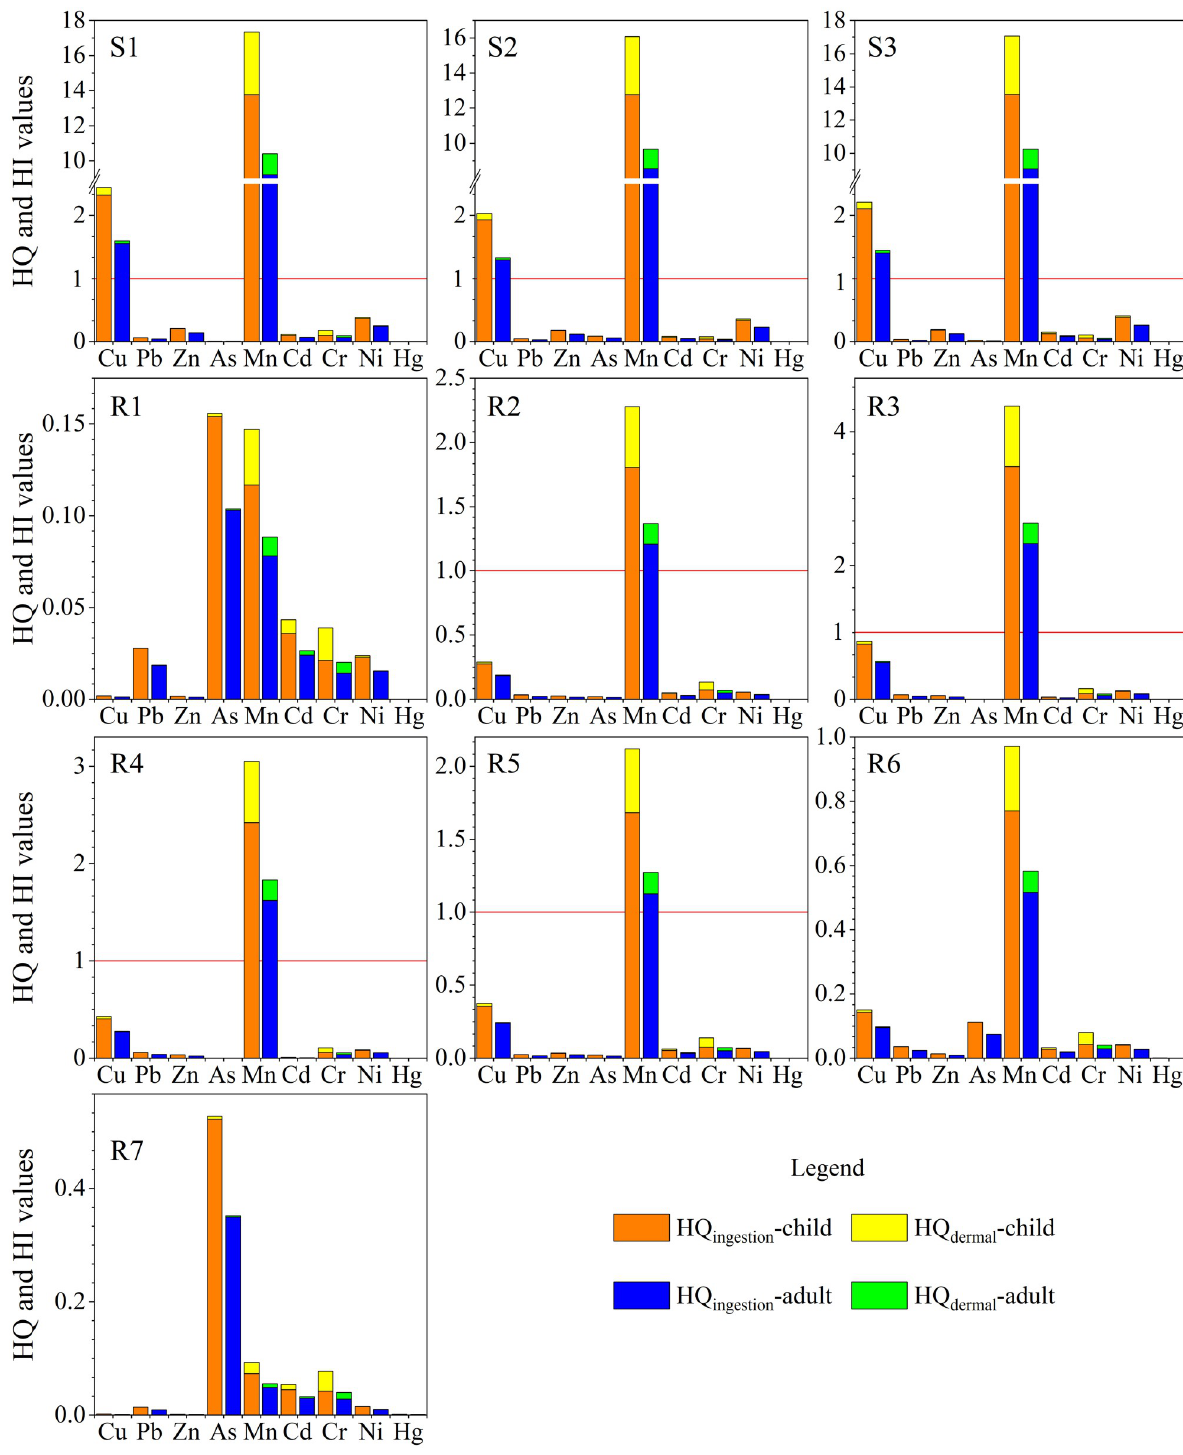
Fig 5. HQ and HI of the Rongna River